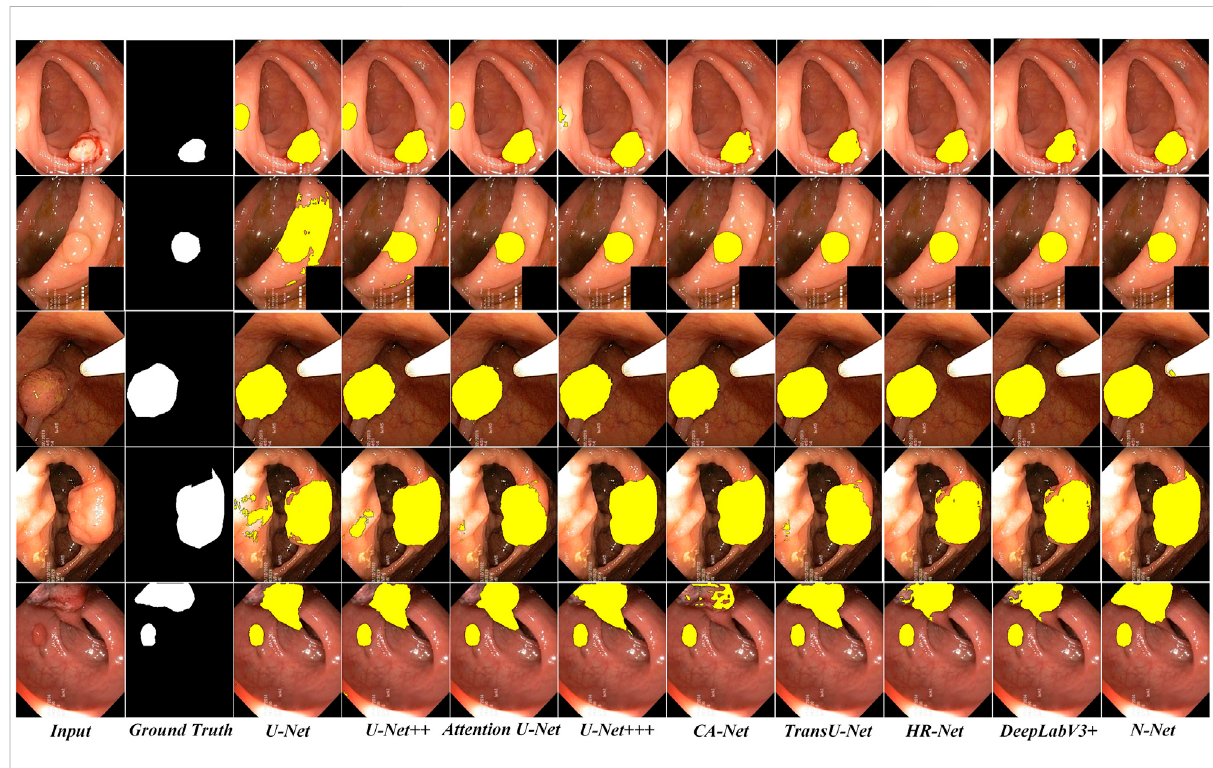
FIGURE 8 Segmentation results of the N-Net and the state-of-the-art methods on representative images of the Kvasir-SEG dataset.